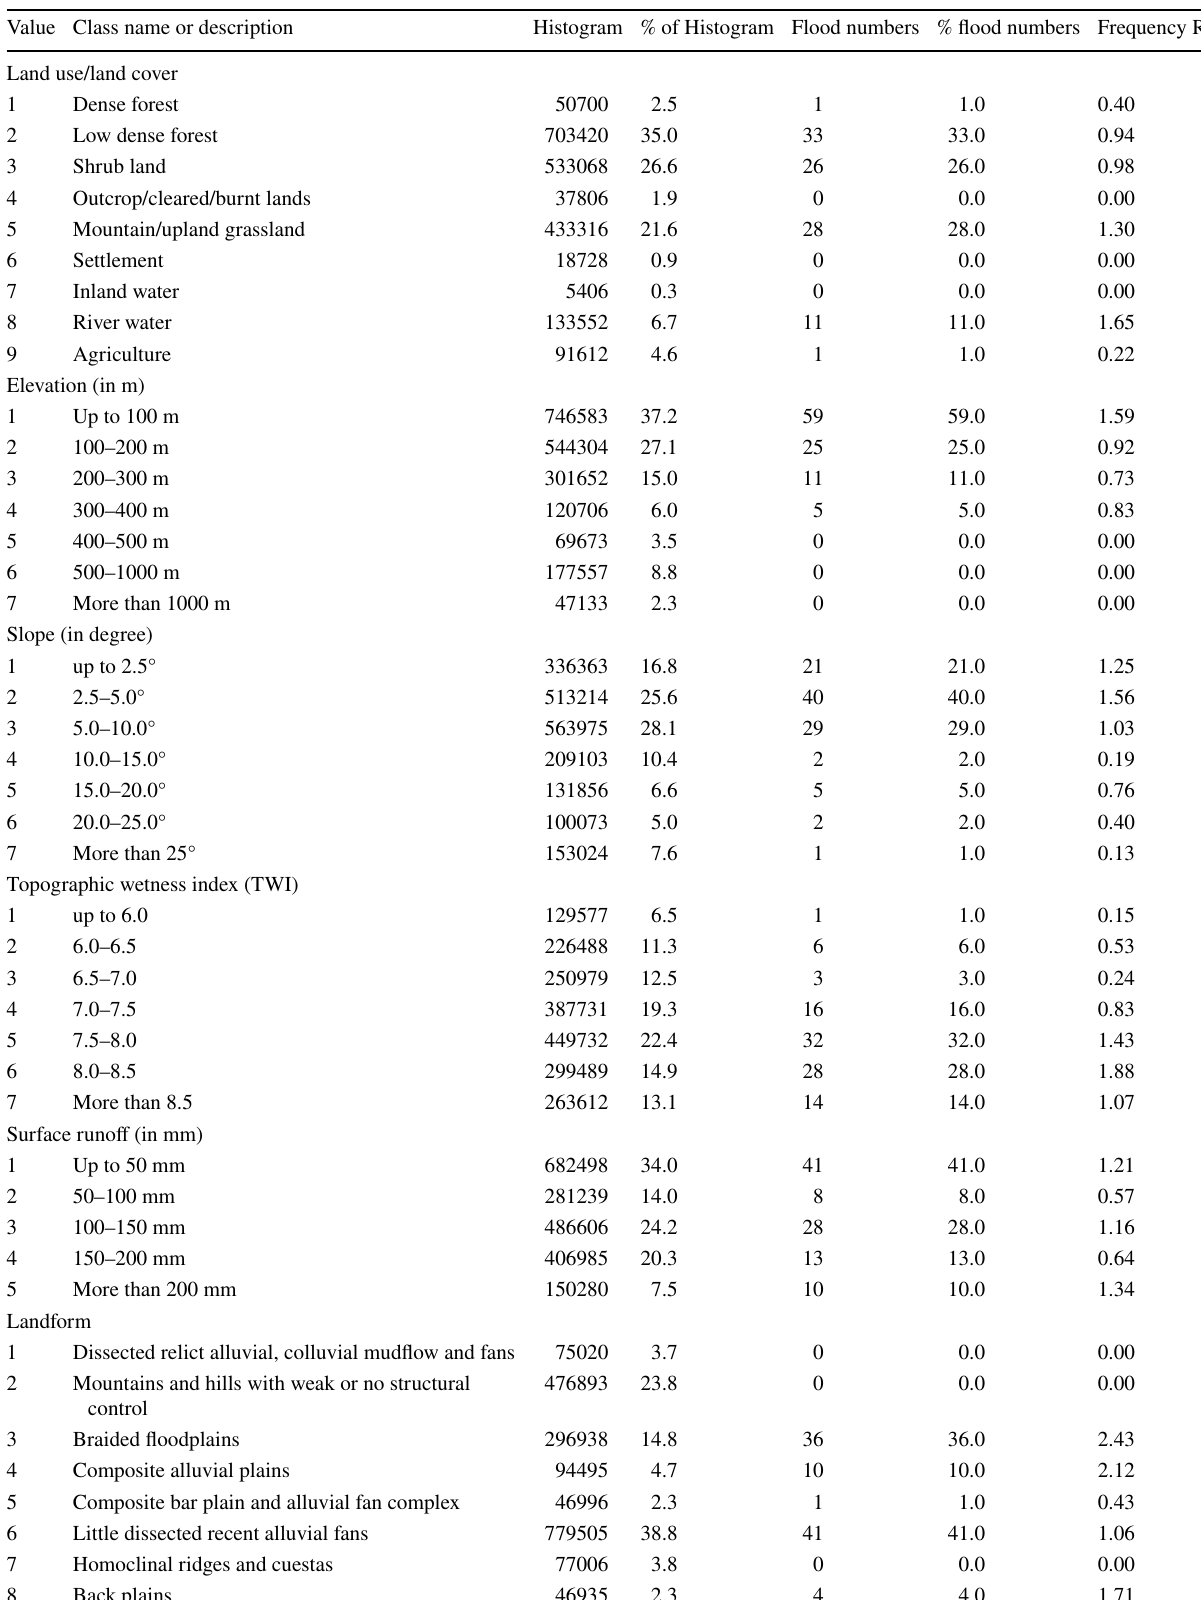
Table 2 Conditioning parameters used for flood vulnerability mapping through FR model Value Class name or